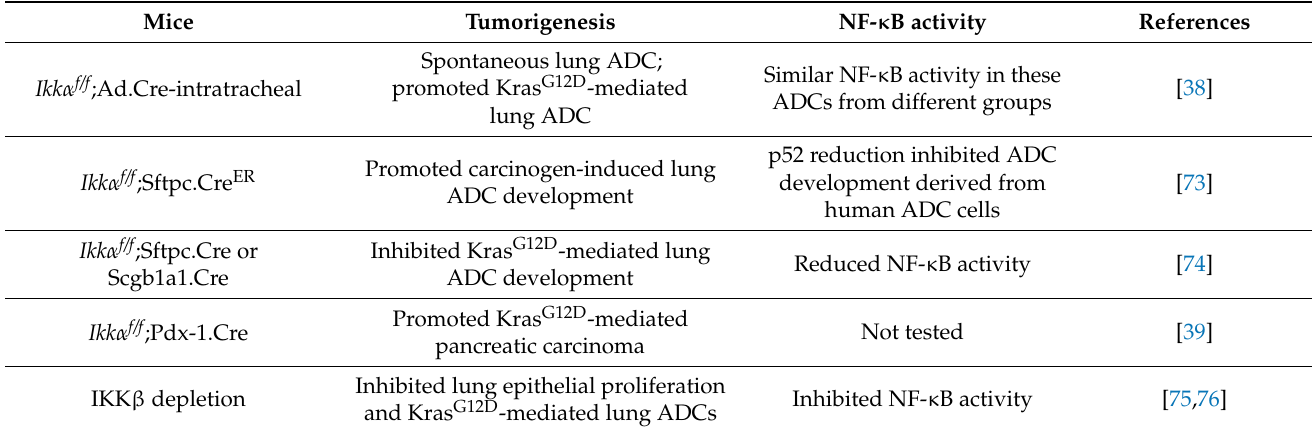
Table 3. Impact of IKK/NF- κ B activities in lung and pancreatic adenocarcinomas (ADCs).